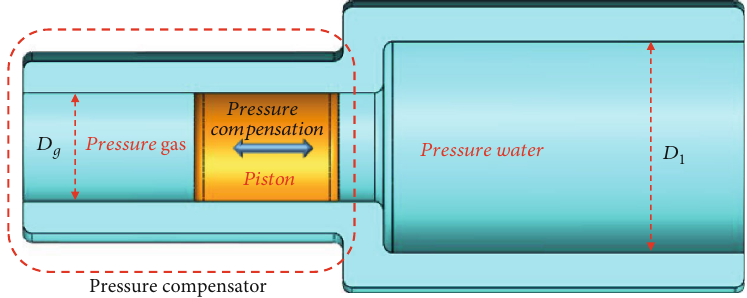
Figure 7: Schematic diagram of the pressure compensation